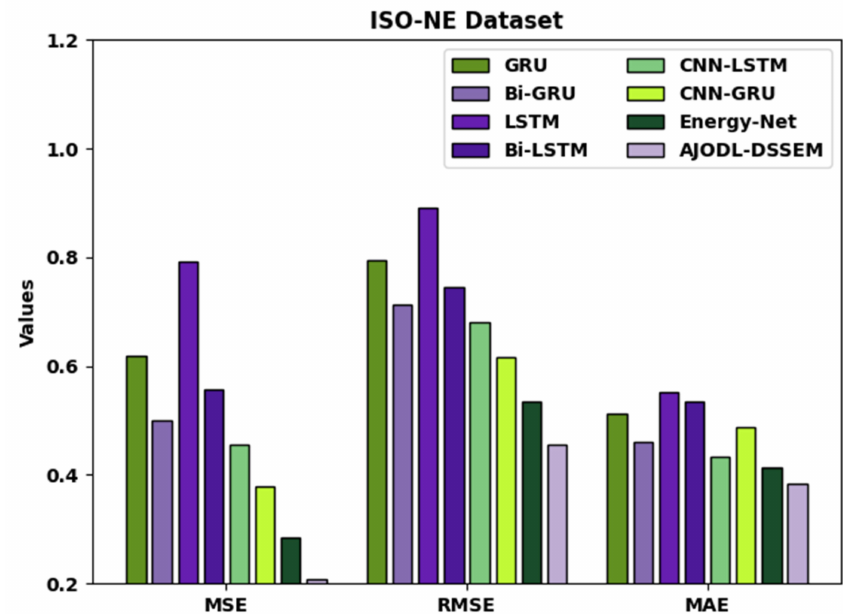
Figure 10. Comparative analysis of AJODL-DSSEM technique under ISO-NE dataset. With respect to the RMSE, the AJODL-DSSEM system obtained an RMSE of 0.384, whereas the GRU, Bi-GRU, LSTM, Bi-LSTM, CNN-LSTM, CNN-GRU, and energy-net techniques ob- tained improved RMSEs of 0.794, 0.713, 0.891, 0.746, 0.681, 0.617, and 0.535, respectively.